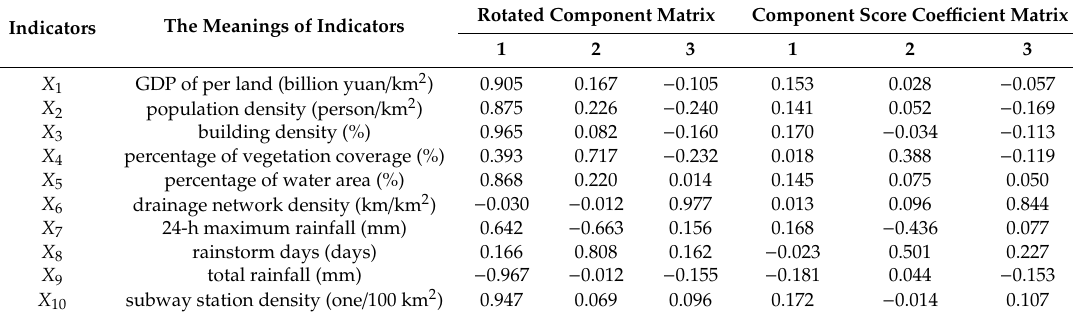
Table 9. Rotated component matrix and component score coe ffi cient matrix.